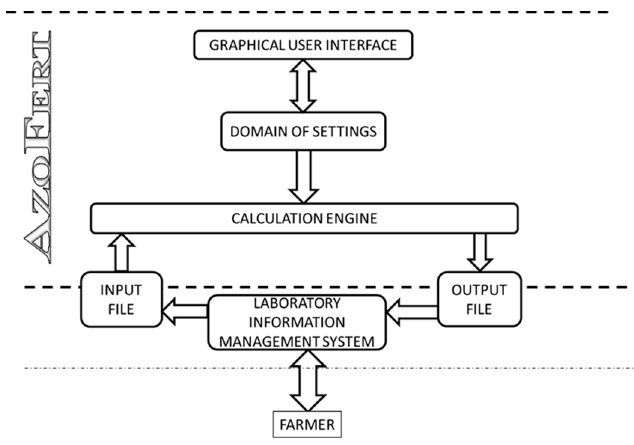
Figure 2. Diagram of the AzoFert ® software and its integration in a data management system.